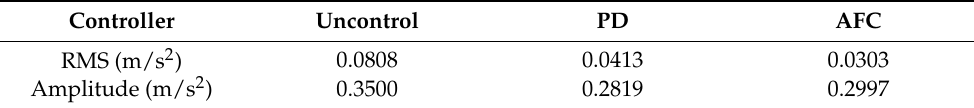
Table 5. Vibration suppression effect of the experimental system for case 2 (  = 2 , 000 ).